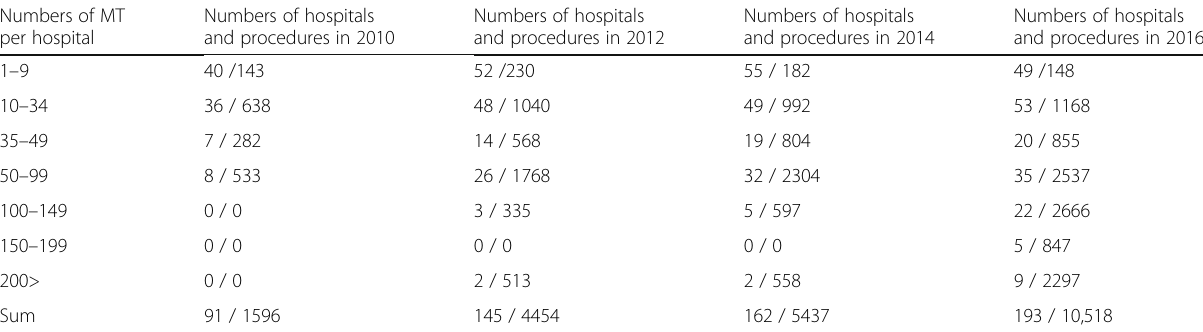
Table 2 German hospitals with a dedicated department of Neurology encoding mechanical thrombectomy (MT, OPS 8 – 836.80) from 2010 to 2016 categorized by numbers of MT performed per hospital and illustration of numbers of MT performed in the categories